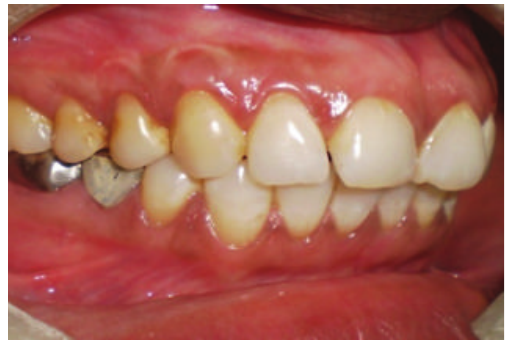
Figure 5: One -year postoperative view. Complete root coverage is observed.